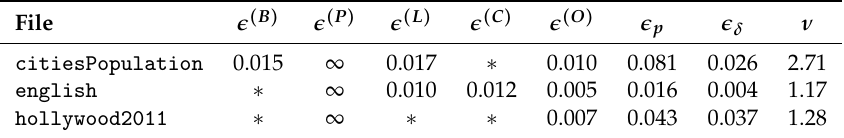
Table 1. Errors and attachment exponents for scalar